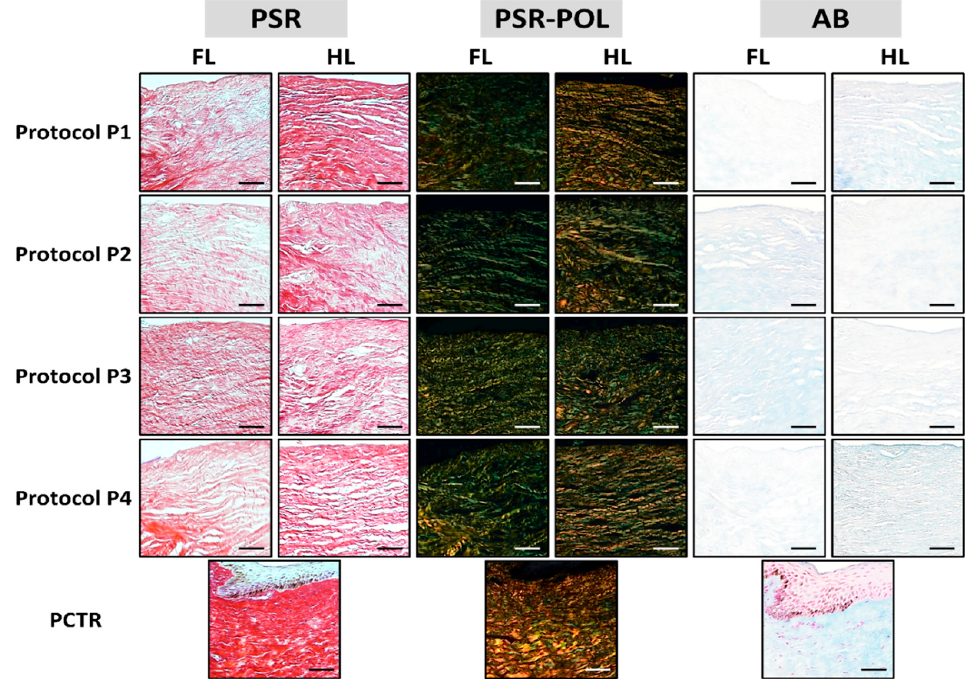
Figure 3. Histochemical analysis of native porcine limbus (PCTR) and decellularized limbi using four different decellularization methods (P1 to P4). Each decellularization protocol was applied to the full ‐ thickness limbus (FL) and the half ‐ thickness limbus (HL). PSR: picrosirius red, PSR ‐ POL: polarized ‐ light picrosirius red, AB: alcian blue. Scale bars: 50 μ m.